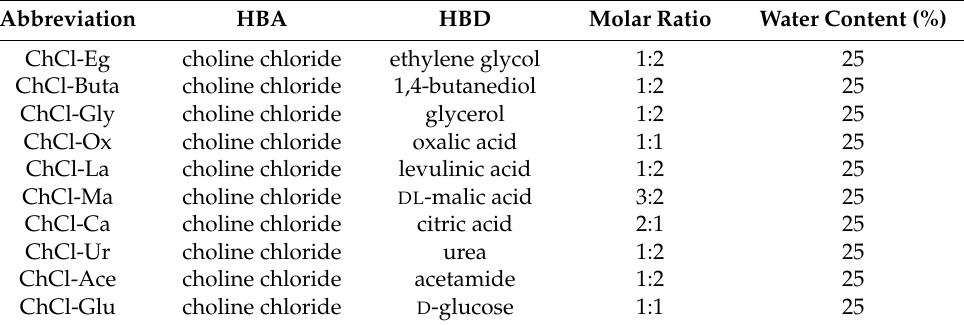
Table 1. 75% ChCl-based DESs solutions tested for extraction.